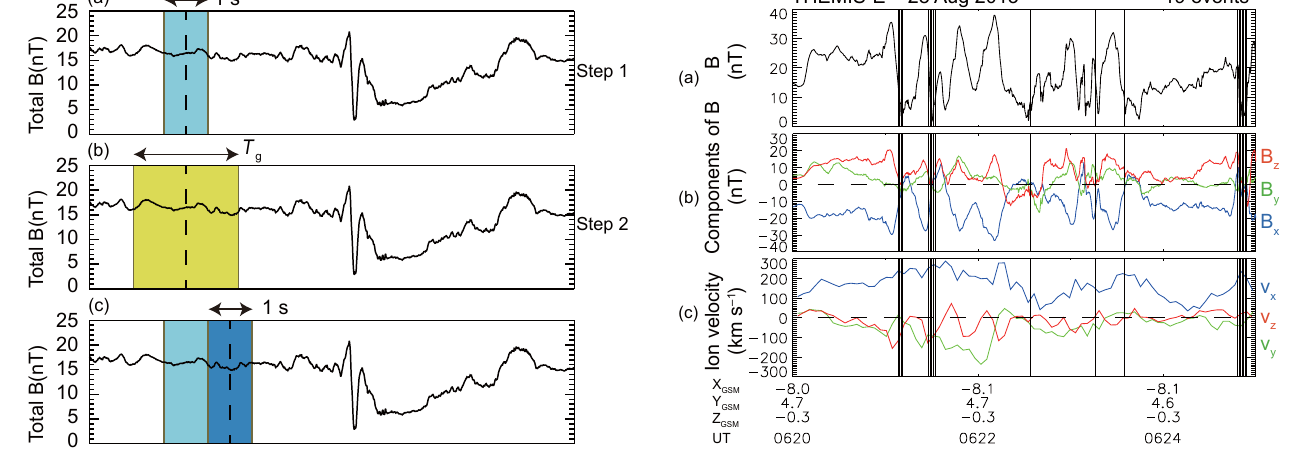
Figure 3. Example multiple-fluctuation events on 28 August 2013. There were 19 severe magnetic fluctuation events.